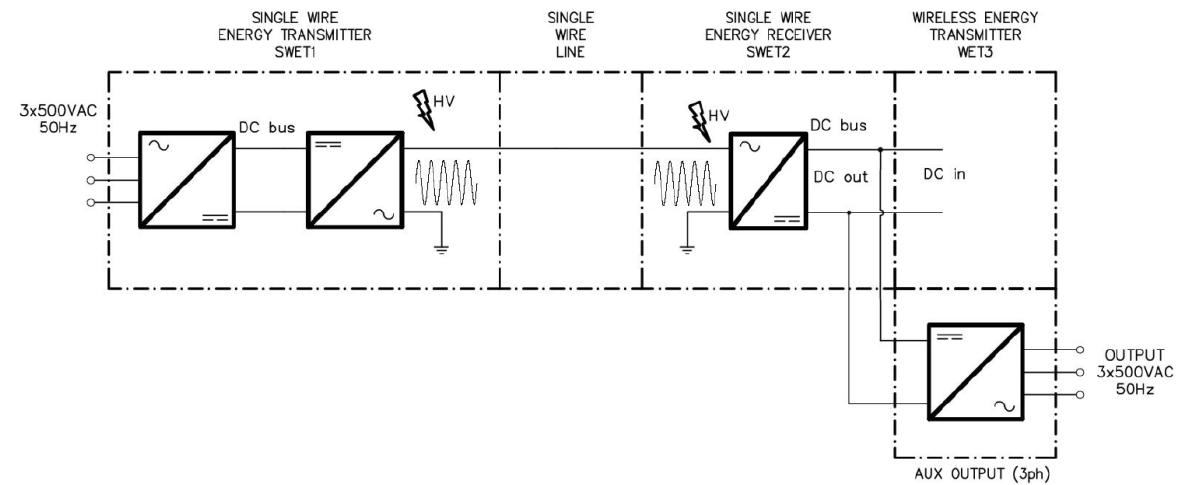
Figure 2. The scheme of energy transfer in an SWET system.